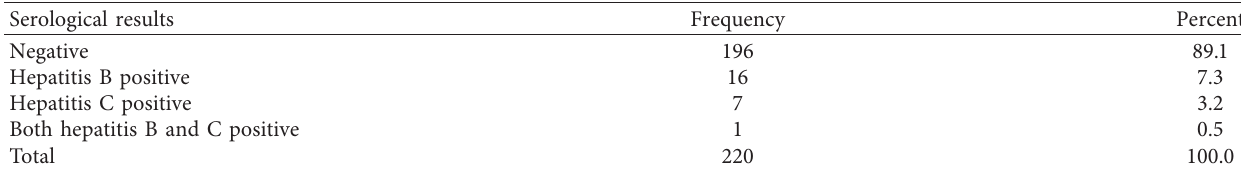
Table 3: The prevalence of HBV and HCV among hemodialysis patients in Somalia.